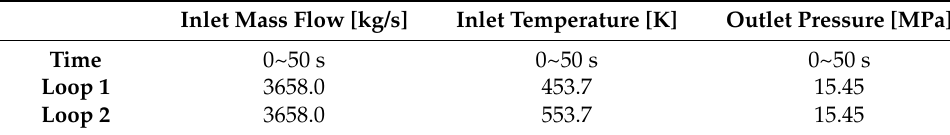
Table 2. The boundary conditions during the transient on the AP1000 reactor.